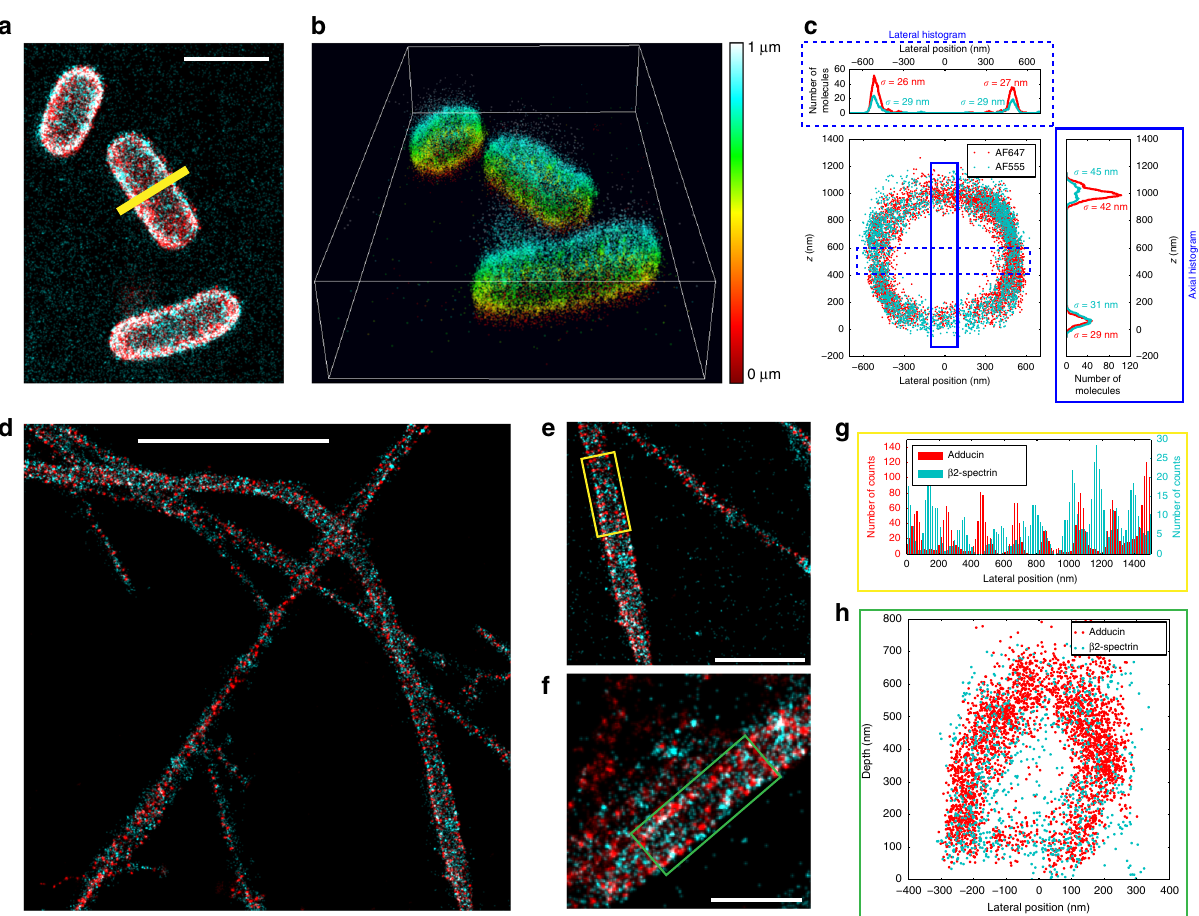
Fig. 3 DAISY results obtained from biological samples. a 2D SMLM image of living E. coli bacteria labeled with both AF647 (red) and AF555 (cyan) at the membrane. b 3D view of the fi eld displayed in a . The depth is color-coded (one single colormap is used for both AF647 and AF555). c x – z slice along the line displayed in a and axial and lateral pro fi les in the boxed regions. The σ values stand for the standard deviations of the distributions. d – f 2D dual-color images of rat hippocampal neurons where the adducin and the β 2-spectrin were labeled with AF647 and AF555, respectively. g Lateral pro fi le along the axis of the yellow box displayed in e . h x – z slice along the green box displayed in f . Scale bars: 2 μ m ( a ) and ( e ), 5 μ m ( d ), 1 μ m ( f